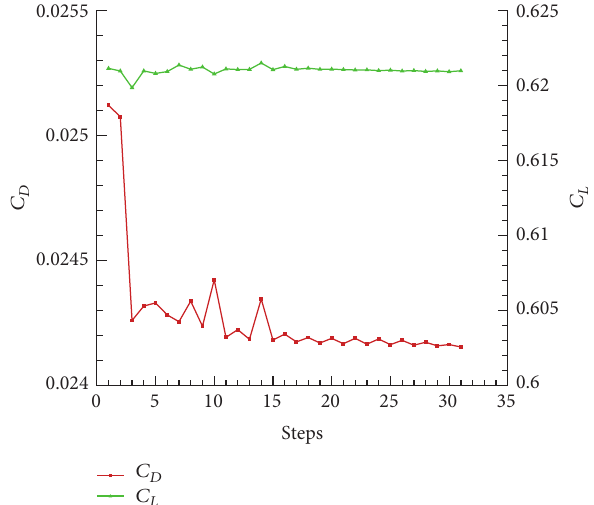
Figure 12: Convergence history for rigid wing design.